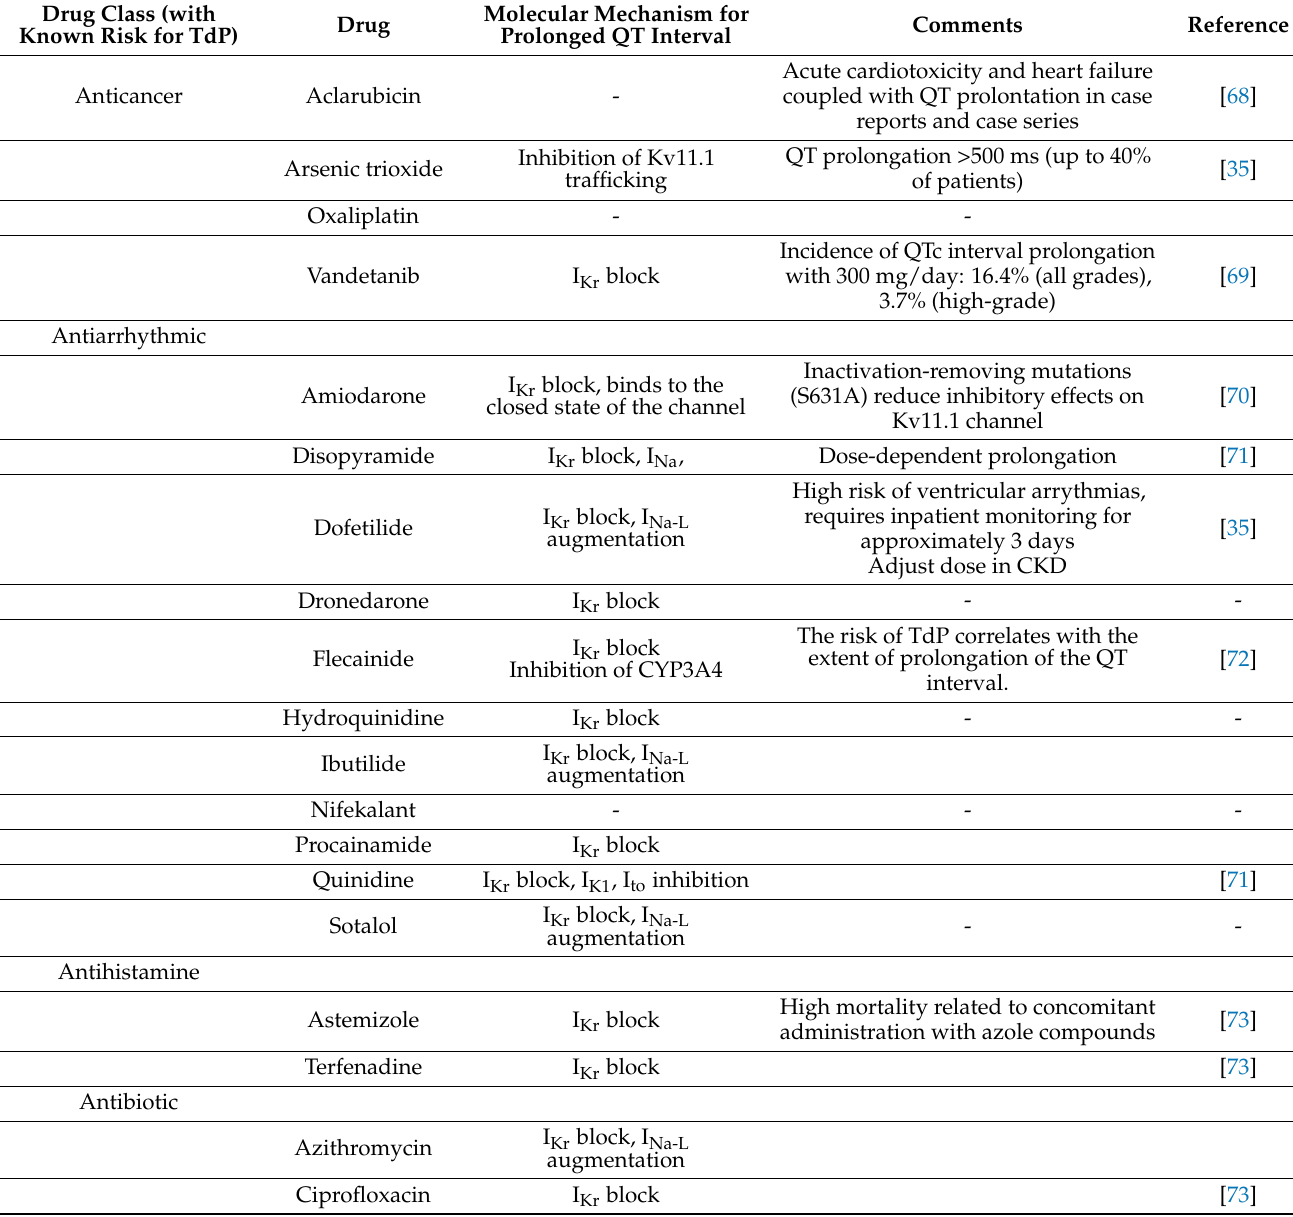
Table 2. Drugs with a known risk of